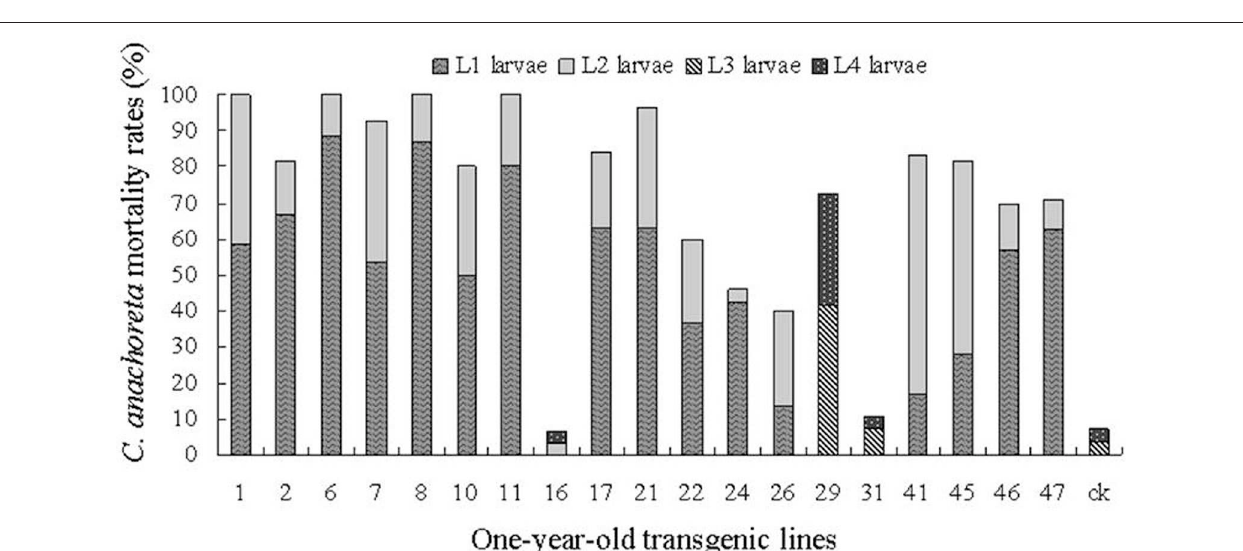
FIGURE 5 | The situation of L. dispar larvae feeding on the leaves of three 1-year-old plants. (1) The situation of L. dispar larvae feeding on the leaf of transgenic line 1. (11) The situation of L. dispar larvae feeding on the leaf of transgenic line 1. (CK) The situation of L. dispar larvae feeding on the leaf of non-transgenic poplar. The L. dispar larvae feed more non-transgenic poplar leaf, but less transgenic line leaves.